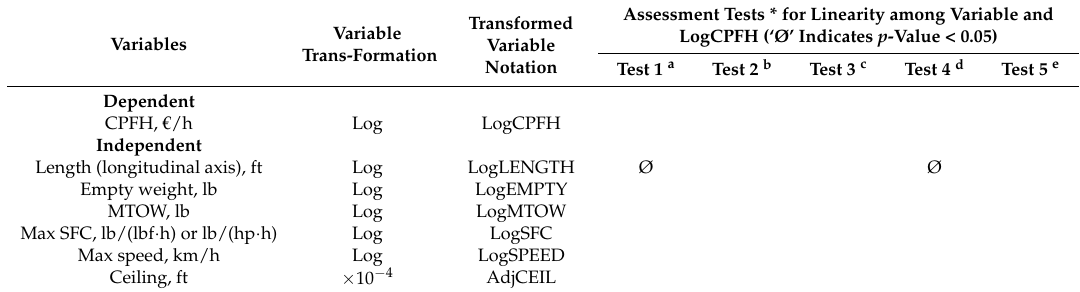
Table 3. The variables used for the analysis. In most cases, the log-transformations contributed to the creation of linear simple CERs versus the LogCPFH (Figure